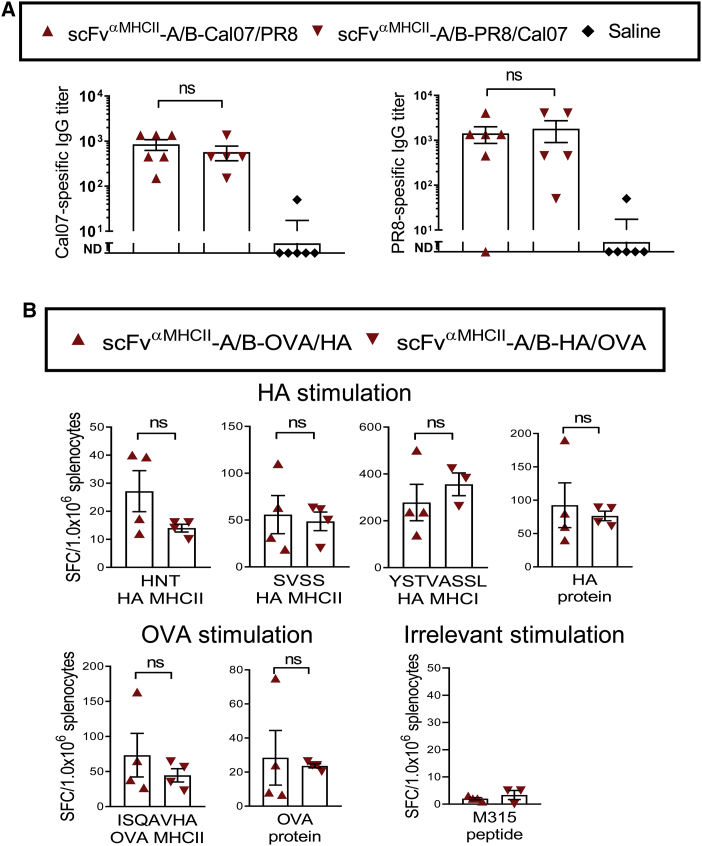
Antigen-Specific Responses Are Induced Irrespective of Whether the Antigen Is Fused to the A or B Arm in the Heterodimeric Vaccine Protein(A) BALB/c mice were vaccinated with 100 μg (two plasmids) of DNA i.m./EP with A/B heterodimers expressing influenza HA antigen from Cal07 (H1N1) and PR8 (H1N1) connected to either the A or B arm (n = 5-6/group). 14 days after vaccination, the mice were bled and Cal07- and PR8-specific IgGs were analyzed in the sera by ELISA (mean ± SEM; Mann-Whitney test, ns, not significant; ND, not detectable). (B) BALB/c mice were vaccinated with 50 μg (two plasmids) of DNA i.d./EP with A/B heterodimers expressing influenza HA antigen from PR8 (H1N1) and OVA connected to either the A or the B arm (n = 4/group, analyzed as biological replicates). After 11 days, spleens were harvested and analyzed for IFN-γ-secreting T cells (ELISPOT) after stimulation with HA whole protein, MHCII-restricted HA peptides (HNTNGVTAACSHEG or SVSSFERFEIFPK), or MHCI-restricted HA peptide (IYSTVASSL), OVA whole protein, MHCII-restricted OVA peptide (ISQAVHAAHAEINEAGR), or irrelevant peptide (λ2315 CDR3 peptide, ALWFRNHFVFGGGTKVT). Mann-Whitney test, two-tailed; ns, not significant.